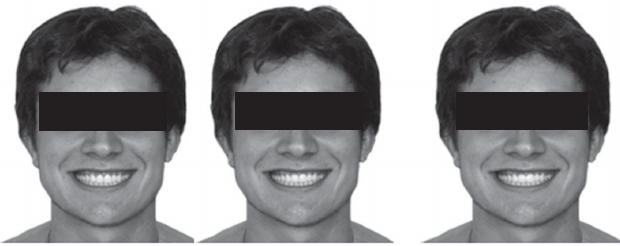
Fig.2 - Male square facial contour set. Each photograph presents a different shape of upper central incisors.